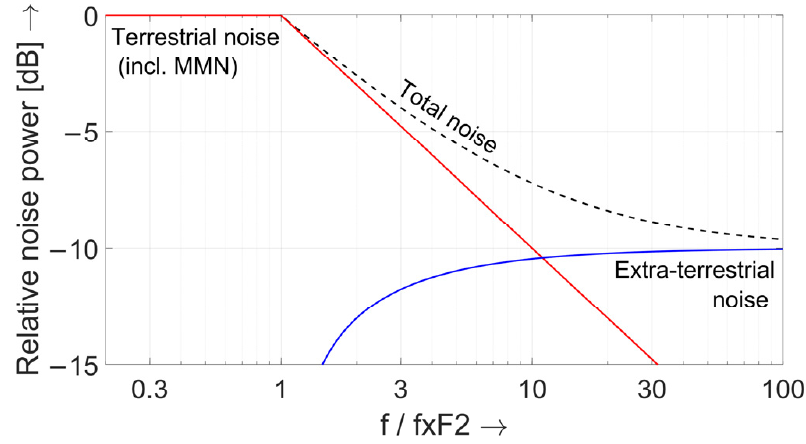
Figure 3. Transition of ambient noise from terrestrial sources reflected by the ionosphere to extra- terrestrial noise arriving through the ionospheric iris (calculated). When the relative levels of the two noise sources are different, the actual transition frequency will also change.